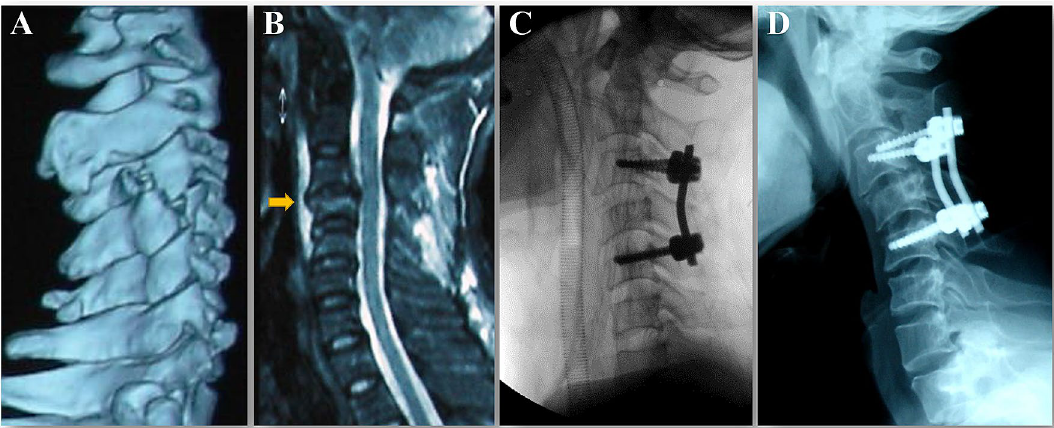
Figure 4. A 39-year-old man who was diagnosed as type IIIA injury pattern of UCLF. Preoperative CT three-dimensional reconstruction showed that a vertical fracture of the C4 right lateral mass created anterior– posterior separation with invagination of the inferior articular process of the cephalic adjacent vertebra ( A ). Cervical vertebral body compression fracture, disc and anterior longitudinal ligament injury, and hematoma in the prevertebral space (yellow arrow) were discovered on sagittal T2-weighted MR image ( B ). The patient underwent posterior facet release and reduction, and C3-5 pedicle screw fixation ( C ). A mild late